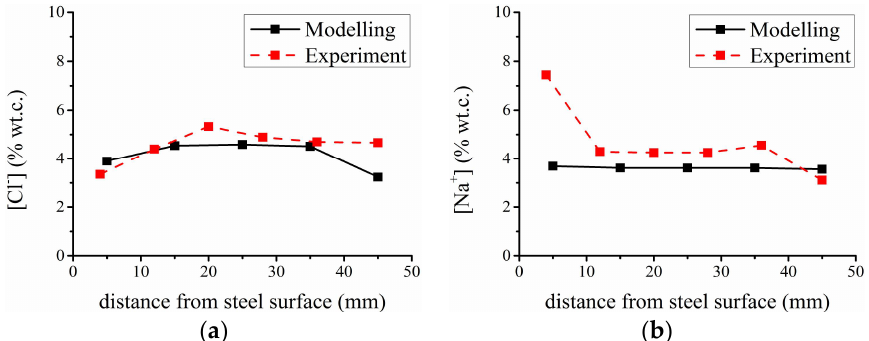
Figure 7. Comparison of the concentration profiles between modelling and the experimental test after the electrochemical treatment of 21 days ( a ) Cl − ; ( b ) Na + .